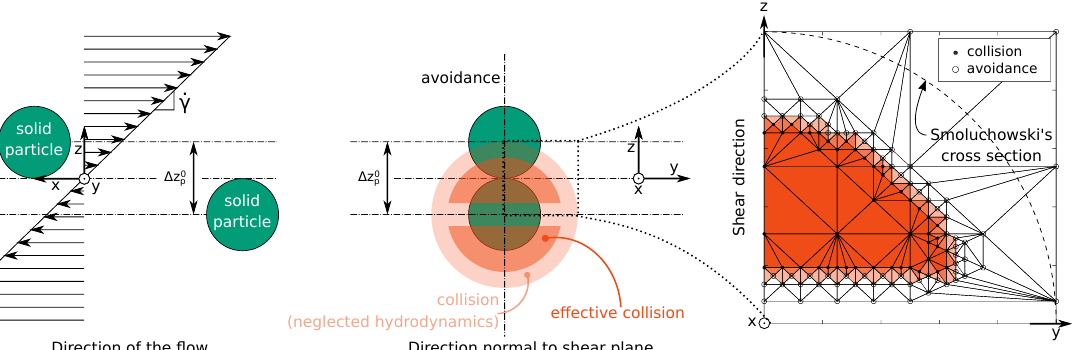
Figure 2. Simulation setup with visible subdivision algorithm to guide the cross-section calculation, the orange region on the right-hand side represents the effective cross-section, with the color intensity level corresponding to the number of nodes of each triangle leading to